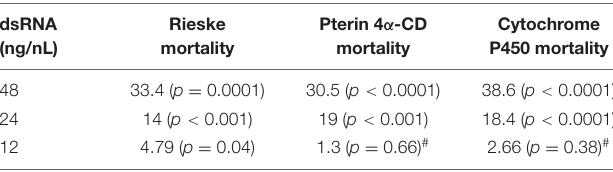
TABLE 2 | Statistical analysis of D. citri mortalities using 2-way ANOVA with Fisher’s LSD test and different concentrations the best three dsRNA diets showing dose response ( Figure 1B ) as compared with diet alone.